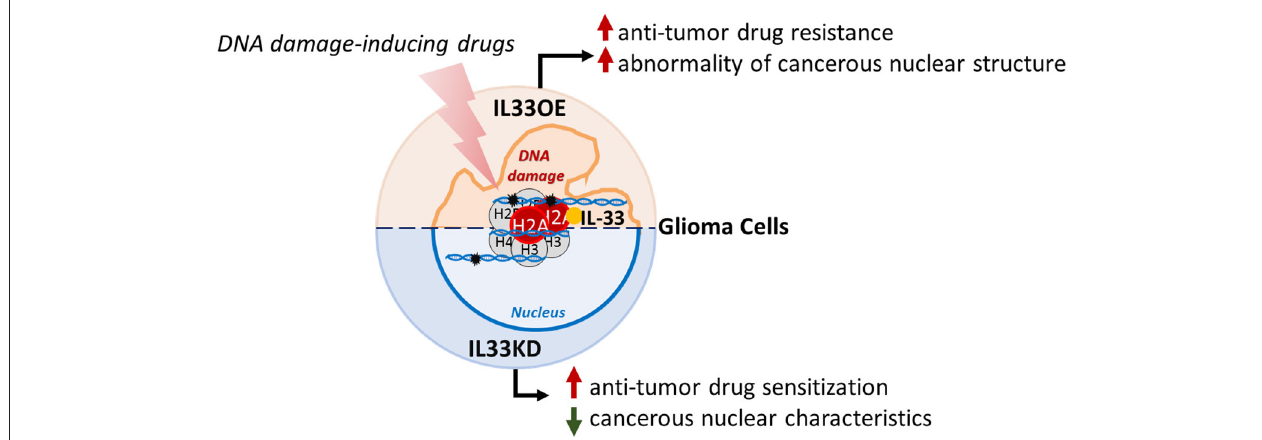
FIGURE 9 | Schematic representation of nuclear IL-33 roles in glioma cells. Nuclear IL-33 interacts with H2A and is associated with chromatins in glioma cells. Declined expression of nuclear IL-33 (IL33KD) increases glioma cell sensitization to DNA damaging drugs and attenuates cancerous nuclear characteristics. In contrast, nuclear IL-33 highly expressed in glioma cells (IL33oe) increases DNA repair capability in glioma cells to induce resistance to the action of DNA damaging drugs and promotes the abnormality of cancerous nuclear structure, such as the formation of multiple nuclear lobes. IL-33, interleukin-33; IL33oe, IL-33